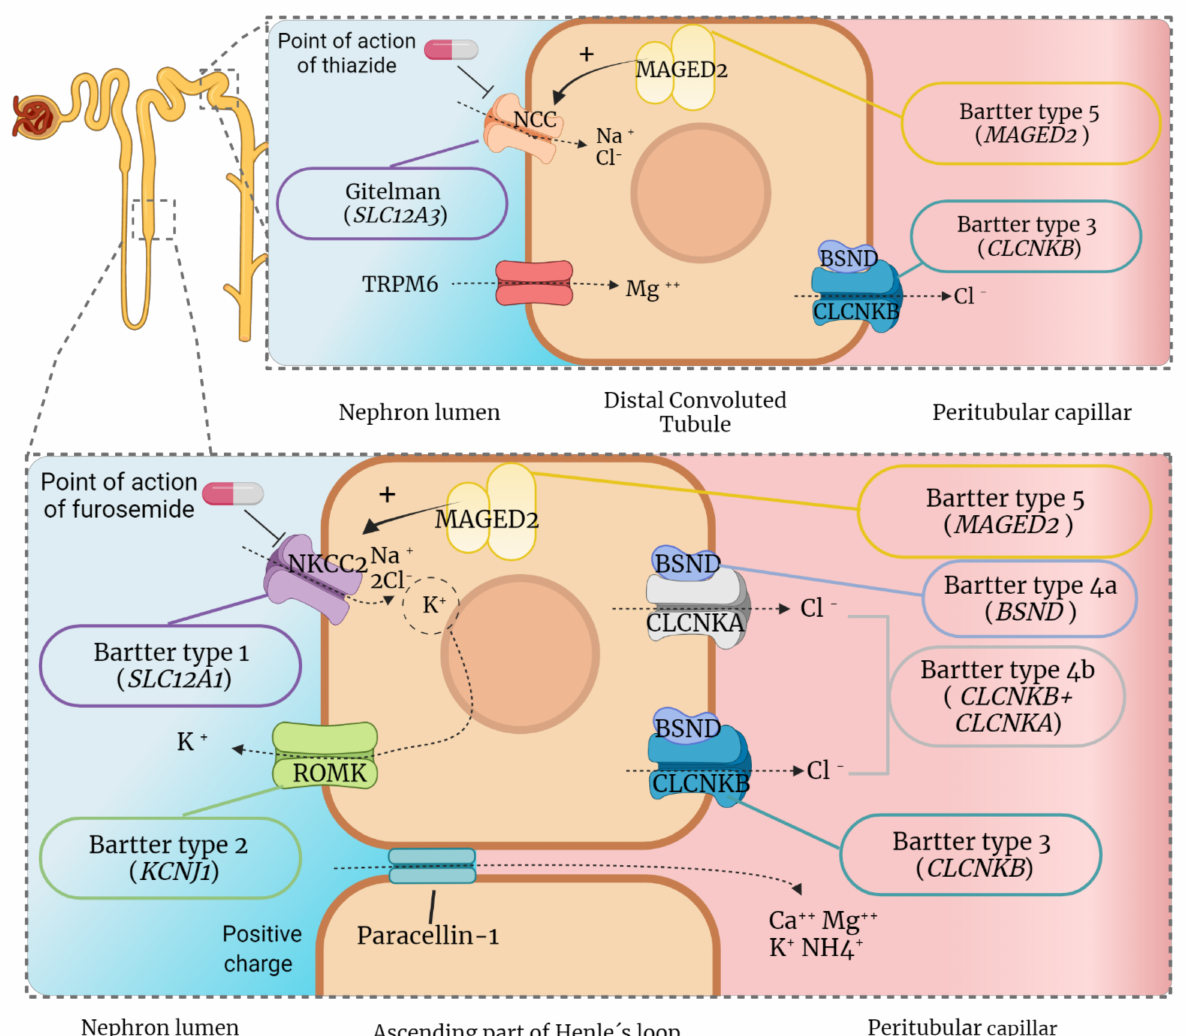
Figure 1. Proteins and channels implicated in the pathogenesis of Gitelman and Bartter syndromes. The electrolyte transports of the most important channels for the diseases are represented as well as the channels related to the inhibition by thiazide (NCC) and furosemide diuretics (NKCC2). Each disease is accompanied by the causative gene (in capital letters, brackets and italics), whereas the corresponding protein is indicated above the channel (only in capital letters). NCC: Solute carrier family 12 member 3; MAGED2: Melanoma-associated antigen D2; TRPM6: Transient receptor potential cation channel subfamily M member 6; CLCNKB: Chloride channel protein ClC-Kb; NKCC2: Solute carrier family 12 member 1; BSND: Barttin; CLCNKA: Chloride channel protein ClC-Ka; and ROMK: ATP-sensitive inward rectifier potassium channel 1. The positive charge of the DCT makes an electrochemical gradient from the luminal tubule from the interstitium